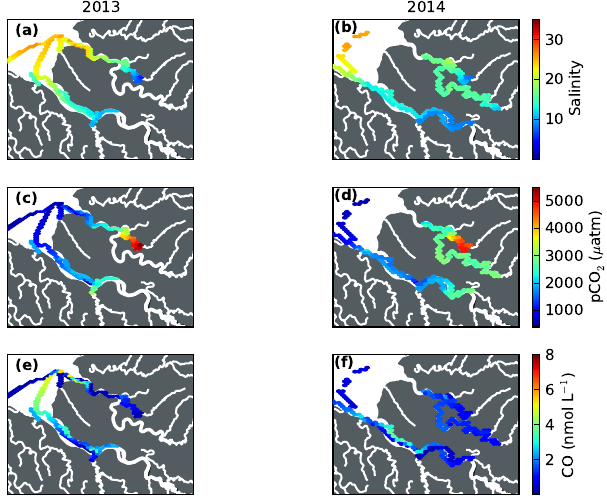
Figure 6. Apparent oxygen utilization (AOU) vs. excess CO 2 . Blue markers refer to samples from 2013; yellow markers refer to sam- ples from 2014. The individual rivers are denoted by different sym- bols.